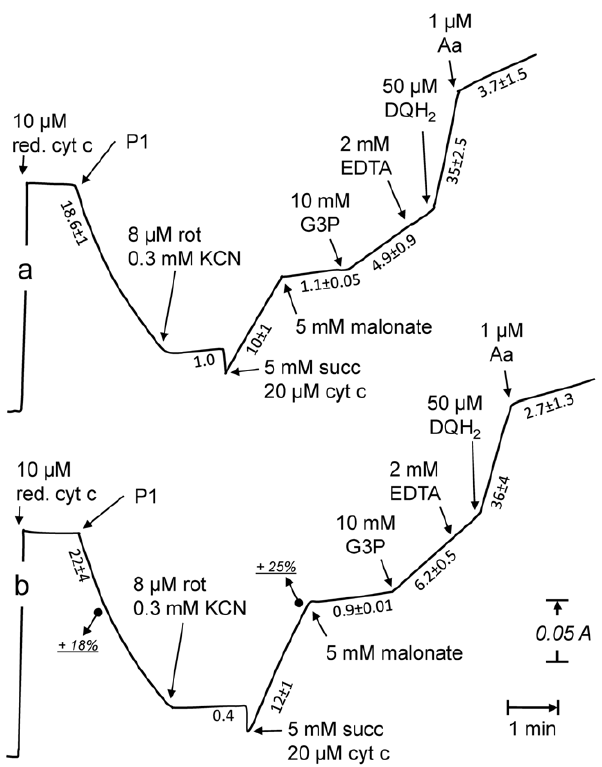
Figure 3. Respiratory chain activities in patient 1 (P1) cells grown in the absence or presence of palmitate. Cytochrome oxidase, estimated by the oxidation rate of reduced cytochrome c (downward deflexion), was about 20% increased in P1 cells cultured with palmitate (comparison traces a and b). Adding cyanide (KCN) fully inhibited the oxidation of cytochrome c . The subsequent addition of succinate (succ), in the presence of rotenone (rot) and additional oxidized cytochrome c , triggered a cytochrome c reduction (upward deflexion) which was essentially sensitive to malonate. This succinate- cytochrome c reductase activity, measuring complex II + III activity, was about 25% higher in P1 cells grown in the presence of palmitate (b). Adding glycerol 3-phosphate (G3P) triggered a new increase of cytochrome c reduction, corresponding to the activity of the glycerol 3-phosphate cytochrome c reductase (glycerol 3-phosphate dehydro- genase + complex III), 40% higher in cells grown with palmitate (b). The subsequent addition of decylubiquinol (DQH 2 ) in the presence of EDTA triggered a rapid cytochrome c reduction which was 90% sensitive to antimycin (Aa). This antimycin-sensitive quinol-cytochrome c reduction (complex III activity) did not differ between cells grown in the absence or presence of palmitate. Numbers along the traces are nmol/min/mg protein. Values are means 6 SEM from triplicate experiments. Experimental procedures as described under Materials and